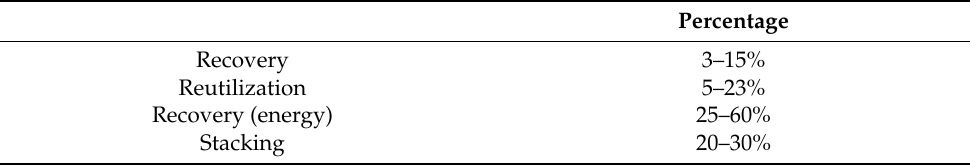
Table 1. Statistics for world waste rubber resource utilization